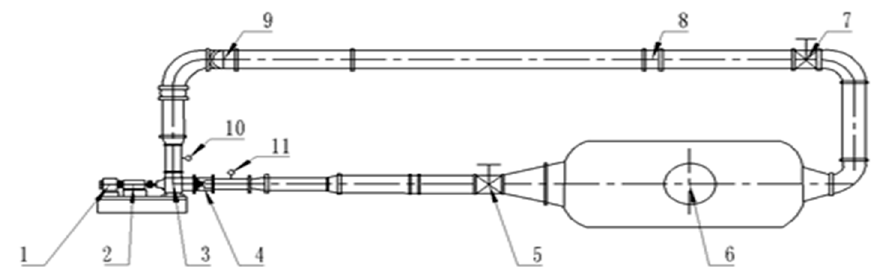
Figure 2. Schematic illustration of the experimental system.